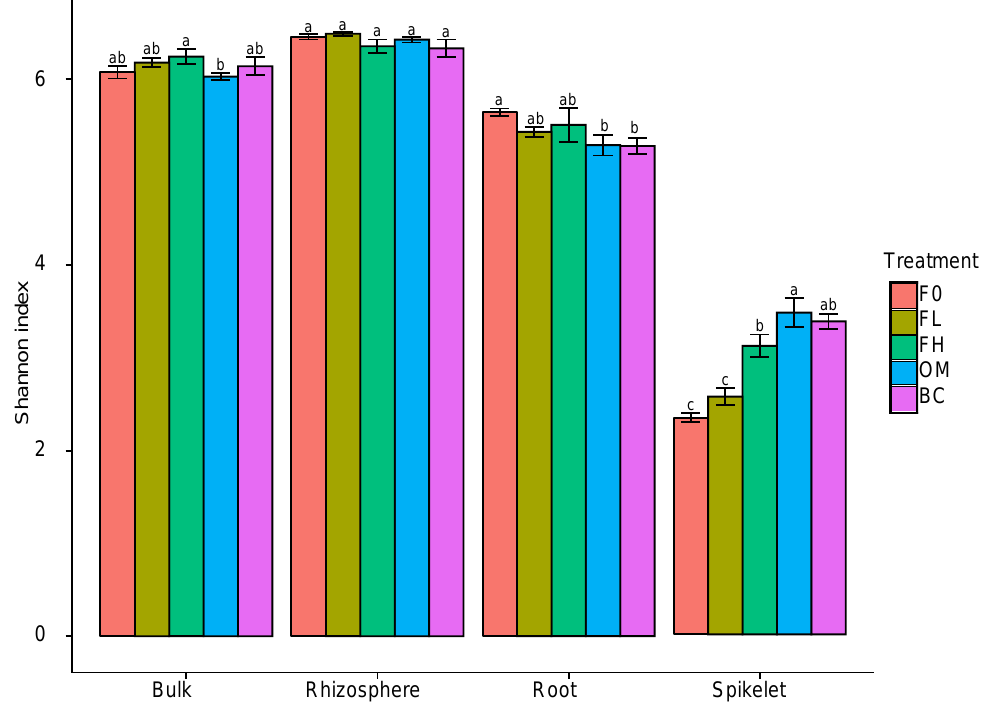
Figure 3. Shannon diversity index (H’) measuring bacterial diversity for different compartments (bulk soil, rhizosphere, root, and spikelet of wheat) at different treatments (chemical fertilizer, manure, and biochar). The same letters above the bars are not significantly different among treatments (ANOVA, LSD test, p ˂ 0.05). FO: no fertilizer, control; LF: low fertilizer; FH: high fertilizer; OM: manure; and BC: biochar.